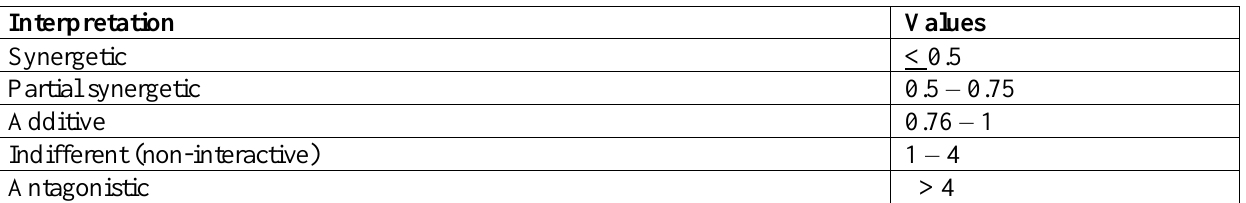
Table 1: Interpretation of the values of ∑FICI.